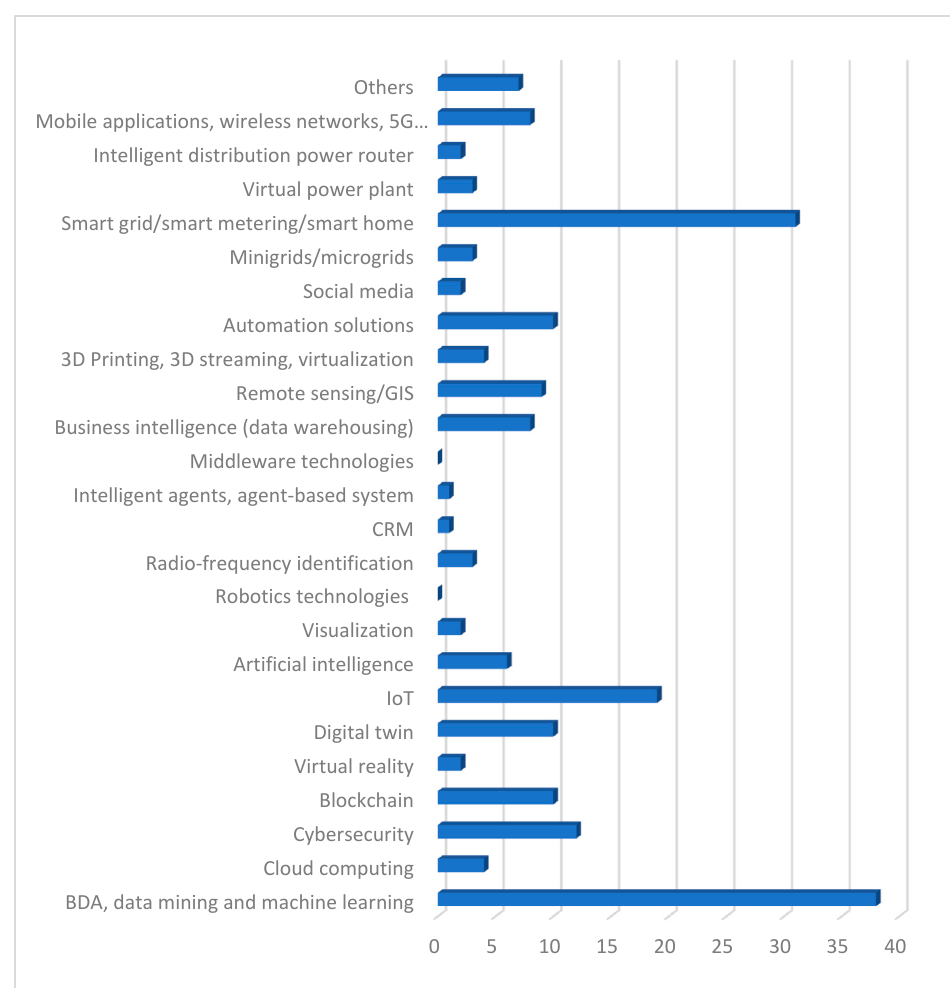
Figure 6. The frequency of appearance of technologies specific to digitalization in studies published during the period 2012–2022.